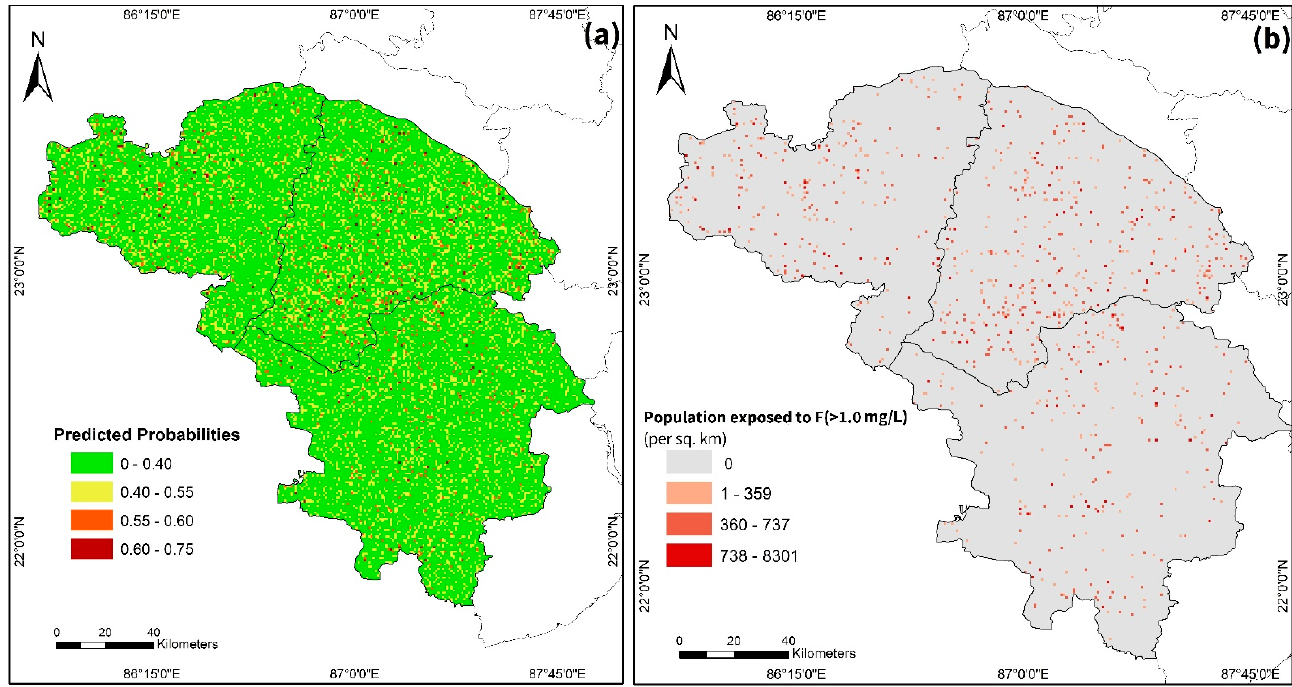
Figure 3. Predicted model maps, ( a ) probabilities of occurrence of groundwater F (>1.0 mg/L), ( b ) the population exposed to groundwater F above 1 mg/L.